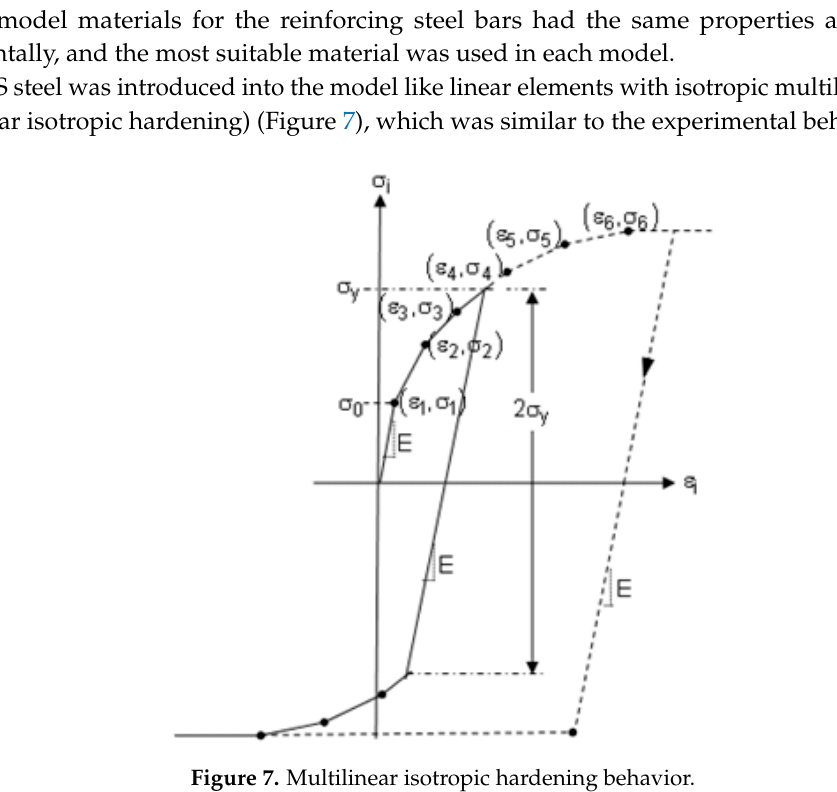
Figure 7. Multilinear isotropic hardening behavior.